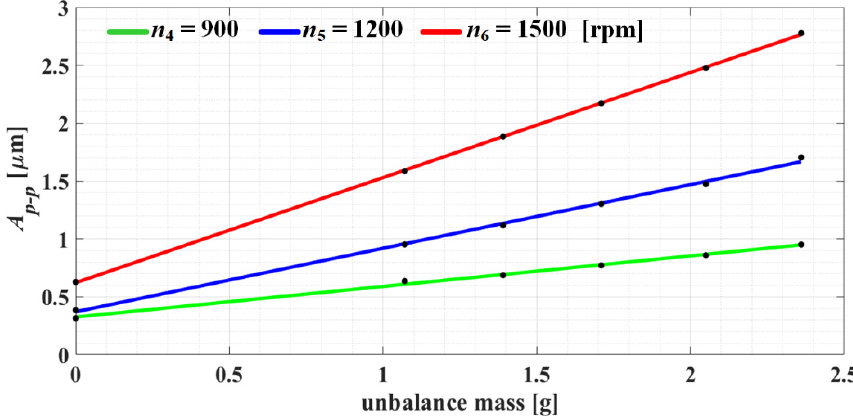
Figure 15. Changes of inter-peak value, A p-p , of vibration displacement as a function of unbalance mass for various rotor rotational speeds.